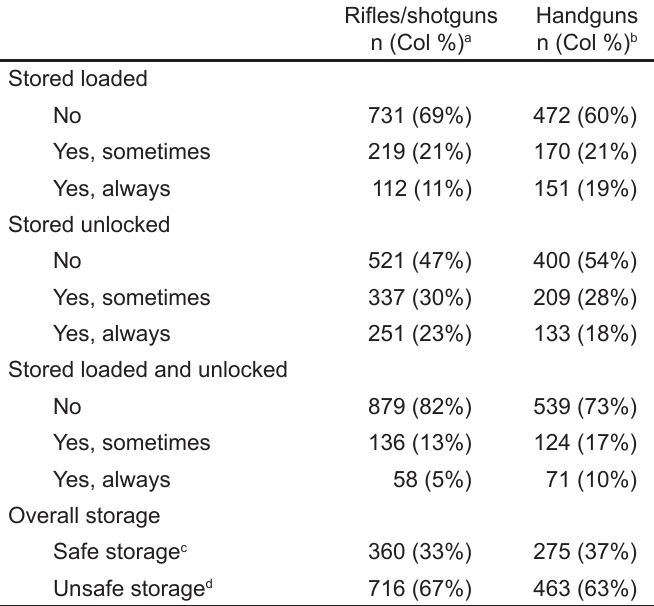
Table 4. Storage of firearms and of handguns in the homes of adolescent survey